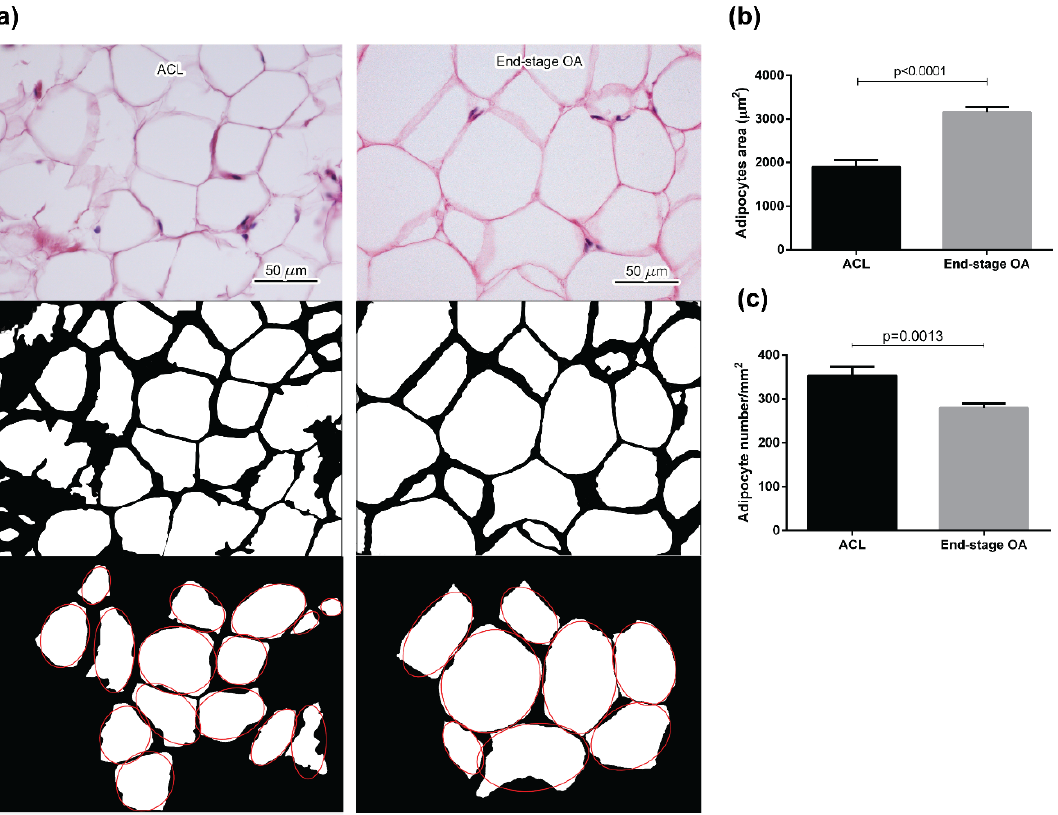
Figure 1. Adipocytes morphology evaluation. ( a ) ACL (on the left) and end-stage OA (on the right) adipocytes were reported from HE stained sections and then converted into the corresponding binary images. For each image, adipocytes areas (white regions) were identified and approximated to ellipses (red line). The comparison between adipocytes area ( b ) and number ( c ) for ACL and end-stage OA (Median and IQR) showed the increment of adipocytes size and the decrease of adipocytes number in OA IFP. ACL = anterior cruciate ligament; OA = osteoarthritis.